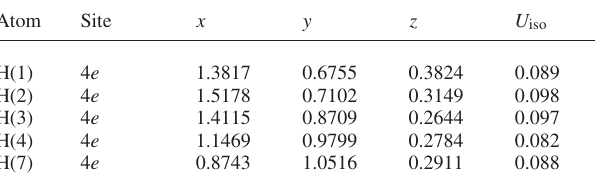
Table 2. Atomic coordinates and displacement parameters (in Å 2 )